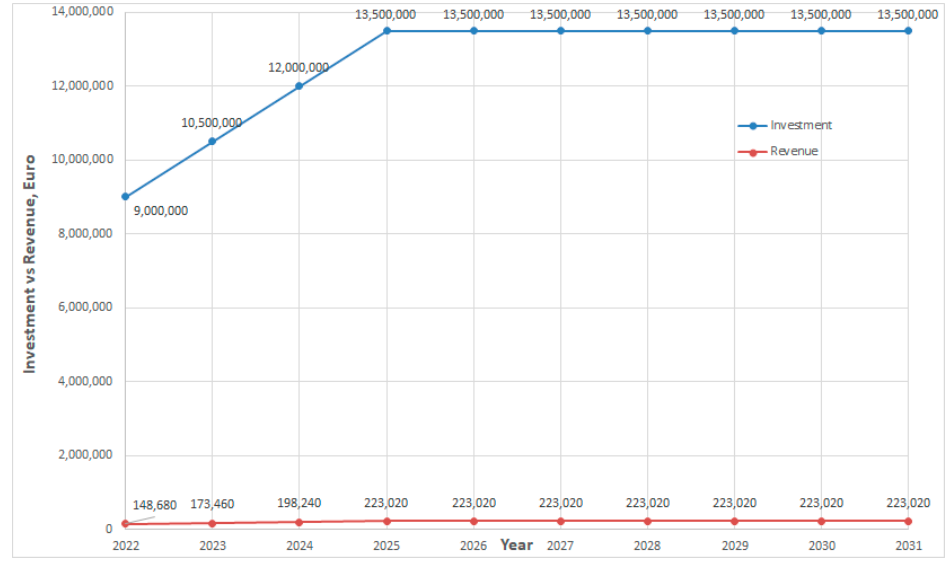
Figure 12. Volume of investment costs and revenues, EUR—scenario 1 (source: authors based on the analysed data).